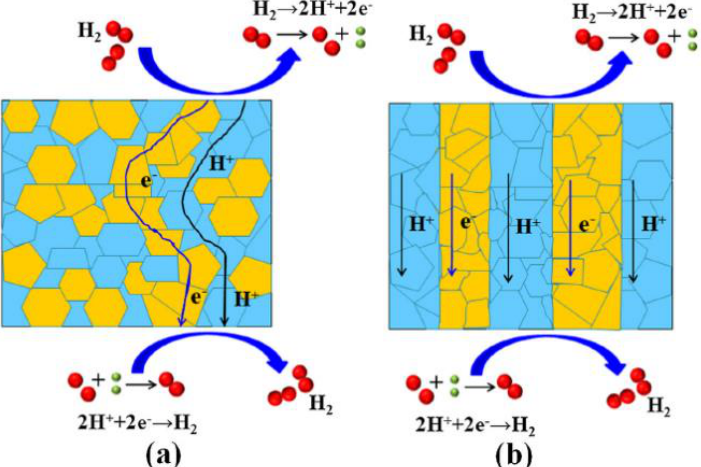
Figure 12. The schematic diagram of the phase distribution and the transport routs of protons and electrons, ( a ) dual-phase membrane prepared by simply powder blending, ( b ) laminated dual-phase membrane with short circuit pathways [74].